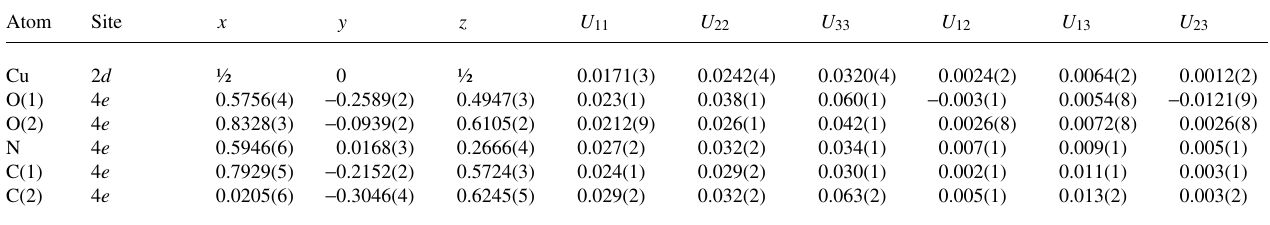
Table 3. Atomic coordinates and displacement parameters (in Å 2 ) .